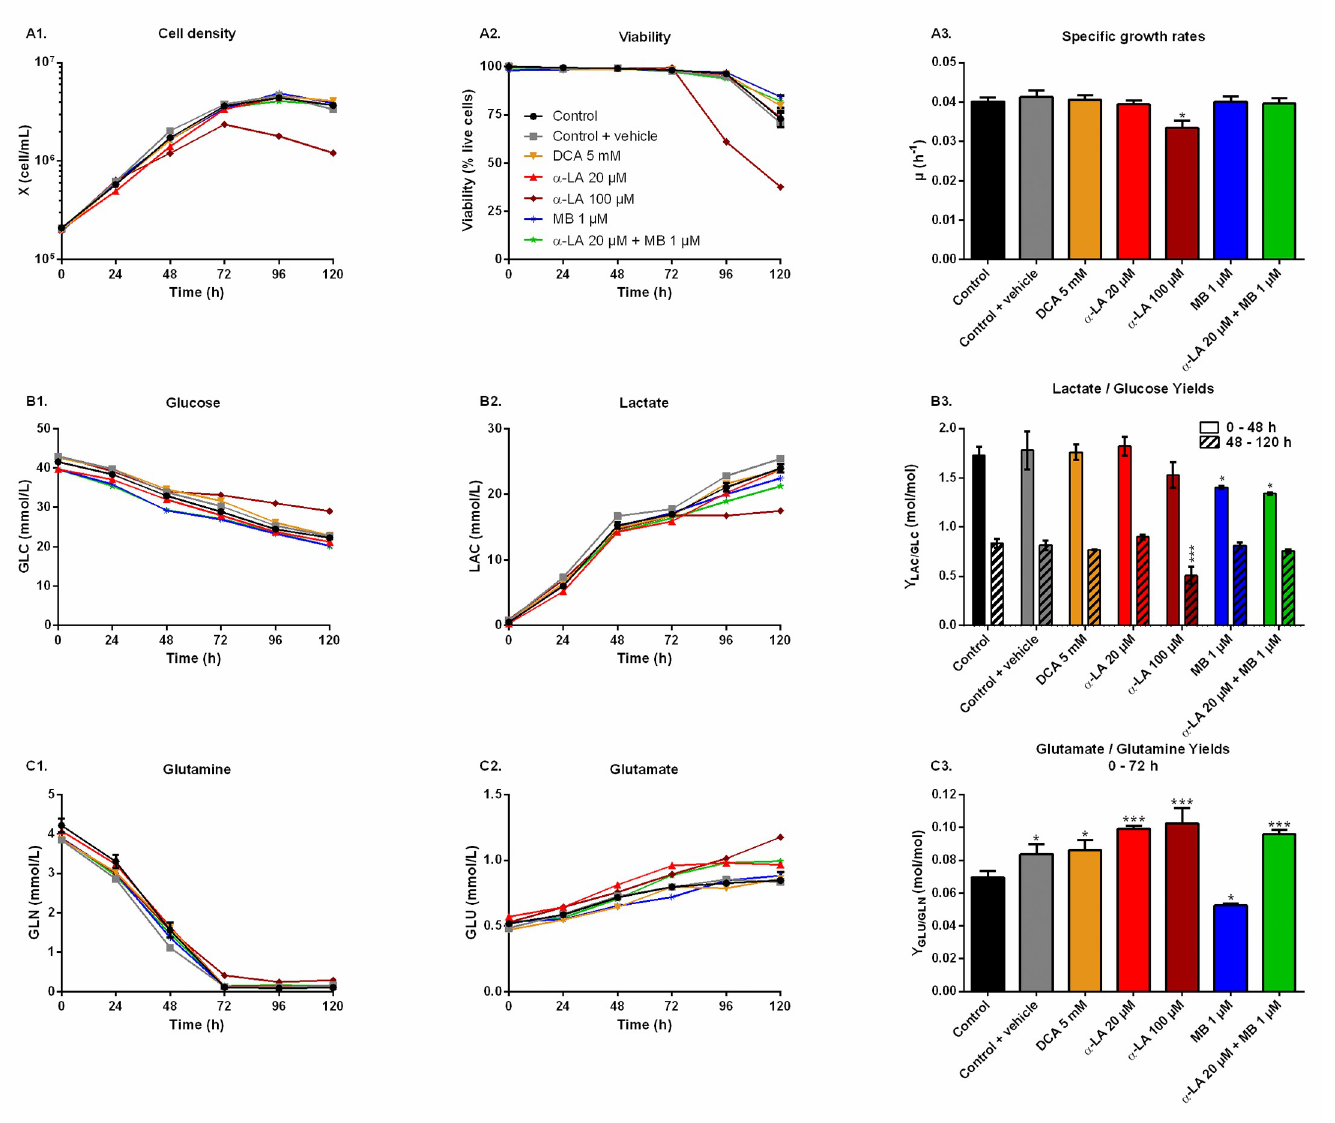
Fig 2. Metabolic responses after drug